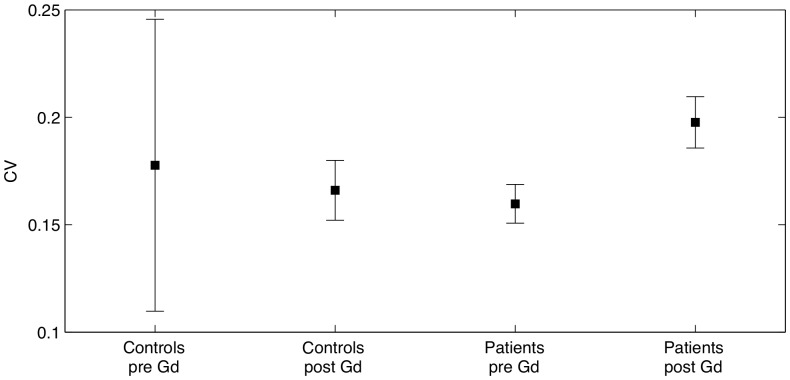
Coefficient of variation of the healthy controls and the patients.The plot shows mean coefficient of variation and 95% confidence intervals. After the injection of contrast agent the mean CV for patients was significantly larger than that of controls. This was not the case prior to the injection of contrast agent.